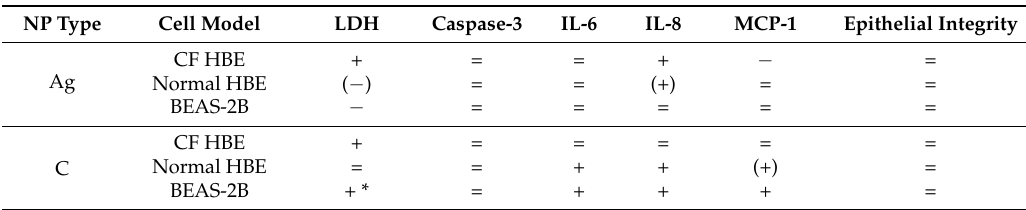
Table 3. Summary of changes in biomarkers in response to NP exposure showing the main contrast to the respective unexposed